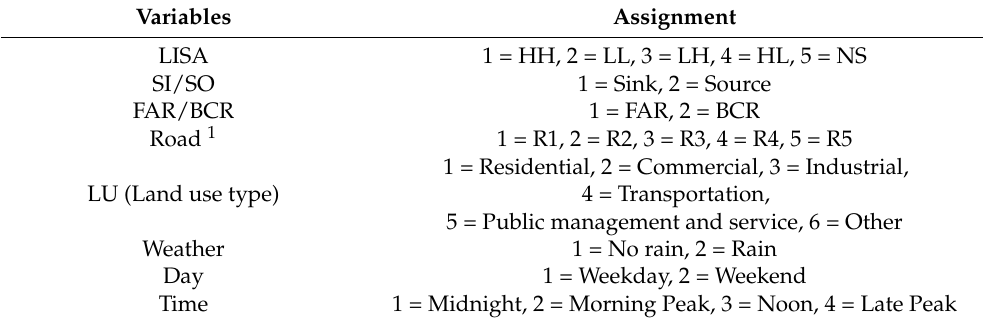
Table 3. Categorical variables and assignmentin correspondence analysis/multiplecorrespondence analysis. Variables